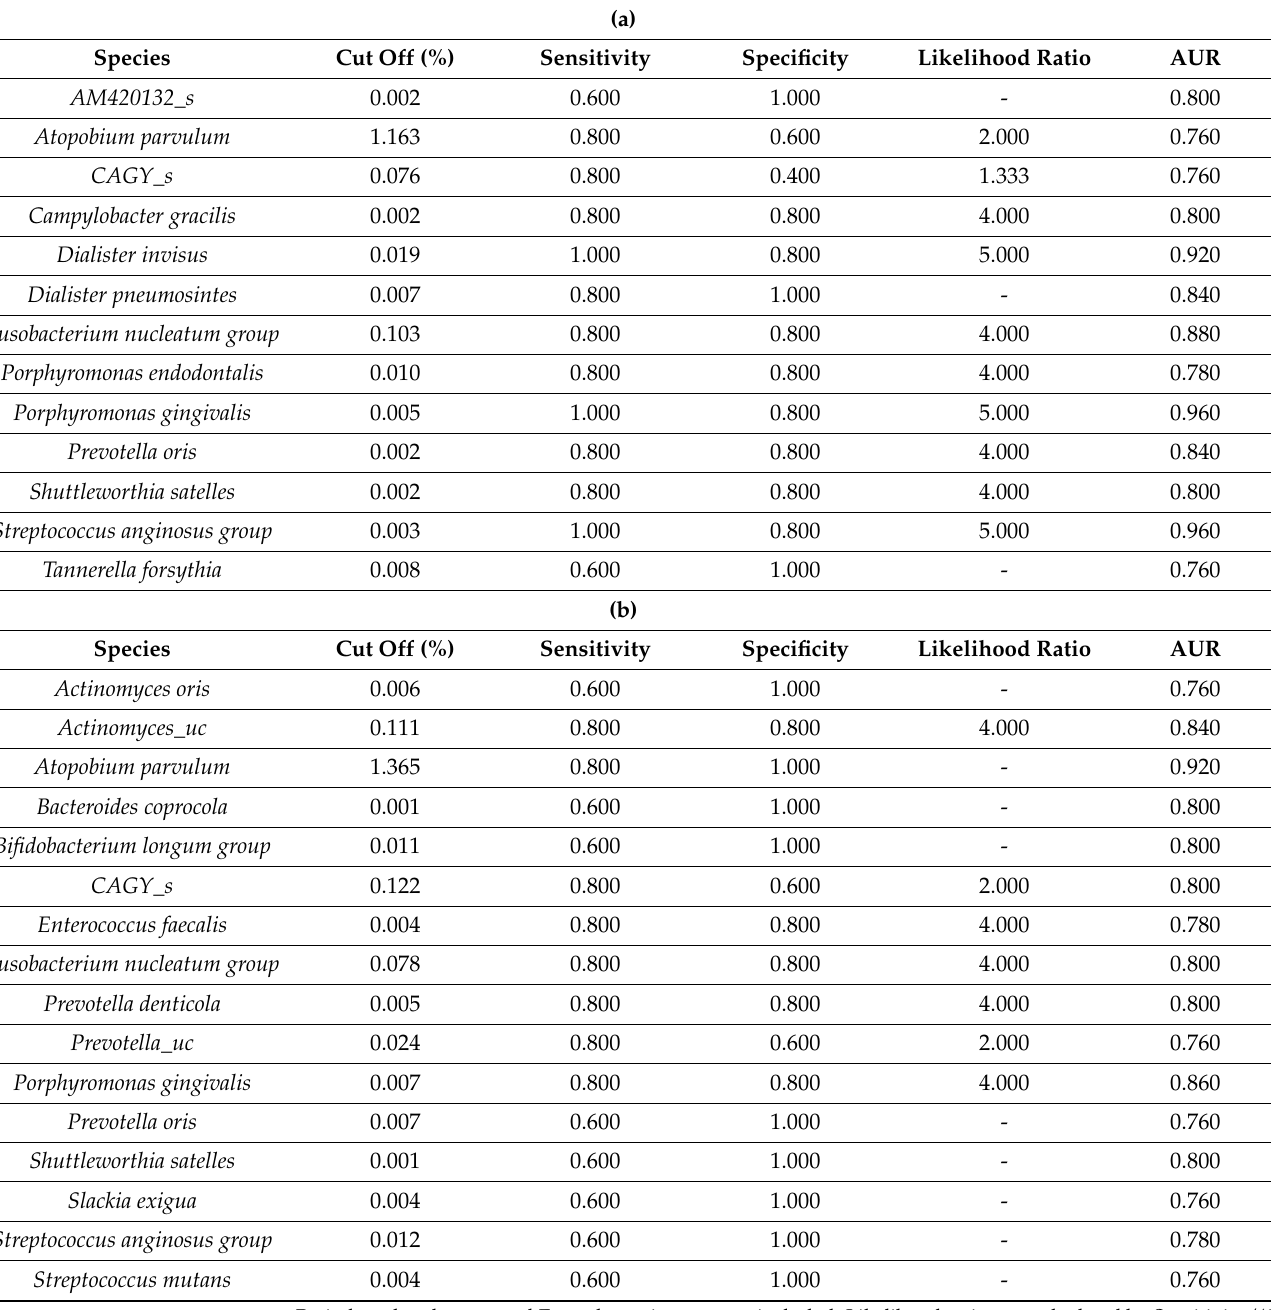
Table 1. Sensitivity and specificity of species levels of oral bacteria for the incidence of fever after operation; ( a ) Baseline; ( b ) Before cancer